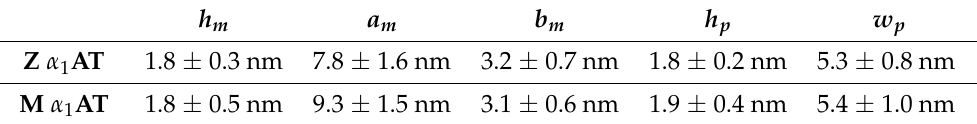
Table 1. Average sizes from the analysis of Figures 1 and 2. h m , monomer height; a m , monomer major axis; b m , monomer minor axis; h p , polymer height; w p , polymer width (orthogonal to the elongation